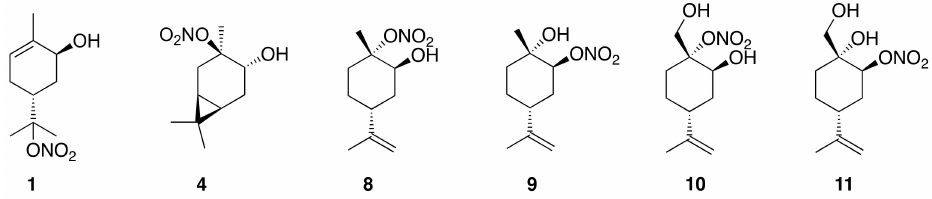
Figure 4. Atmospherically relevant hydroxynitrates in this